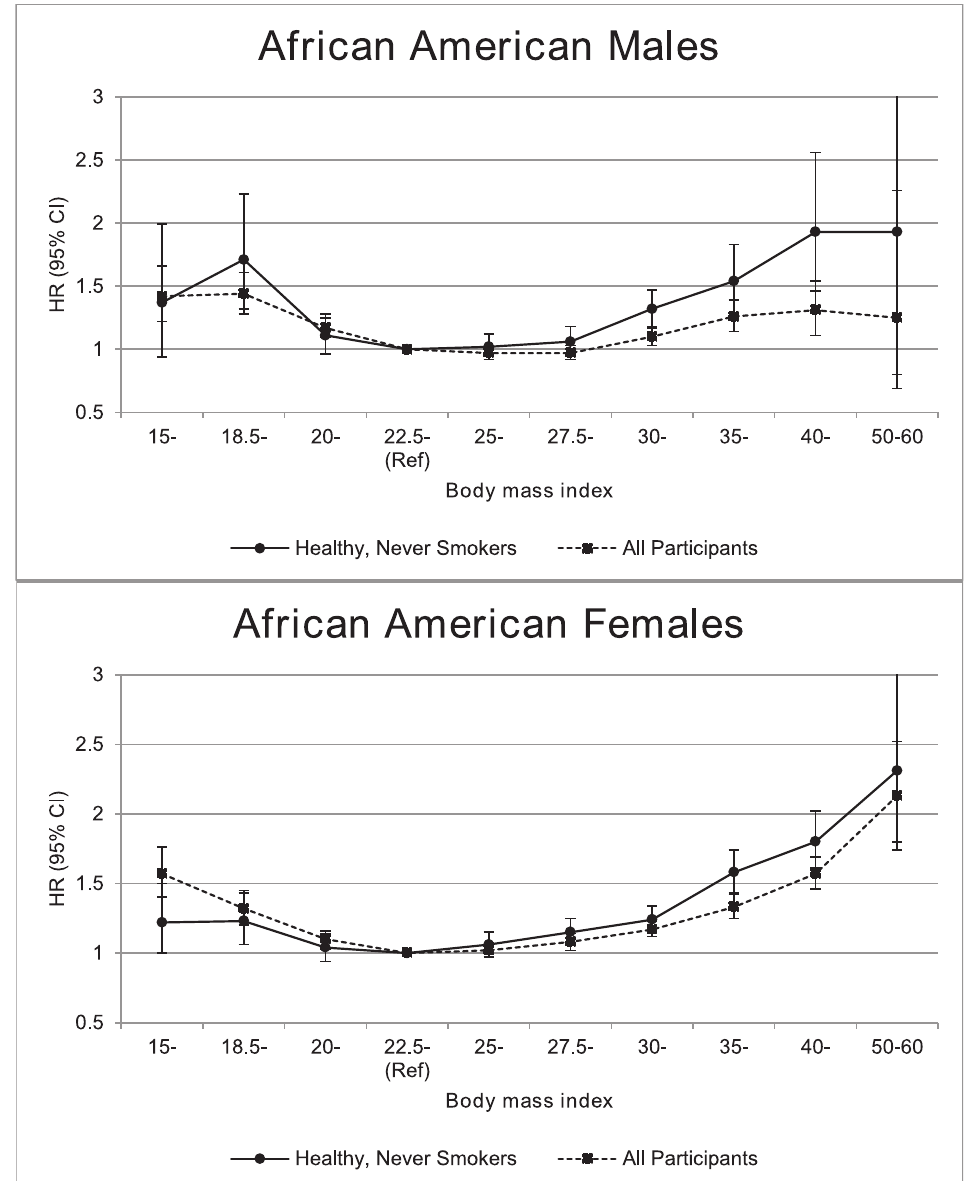
Figure 1. Association between body mass index and all-cause mortality, stratified by sex. Hazard ratios (HR) and 95% confidence intervals (CI) from multivariate Cox proportional hazards models for the association between body mass index (BMI) and all-cause mortality among never smokers with no baseline chronic illness (including heart disease, stroke, or cancer of any type except non-melanoma skin cancer), and among all participants, stratified by sex. NOTE: All models stratified by cohort and adjusted for education, marital status, alcohol consumption, and physical activity. Models including all participants were further adjusted for cigarette smoking status.